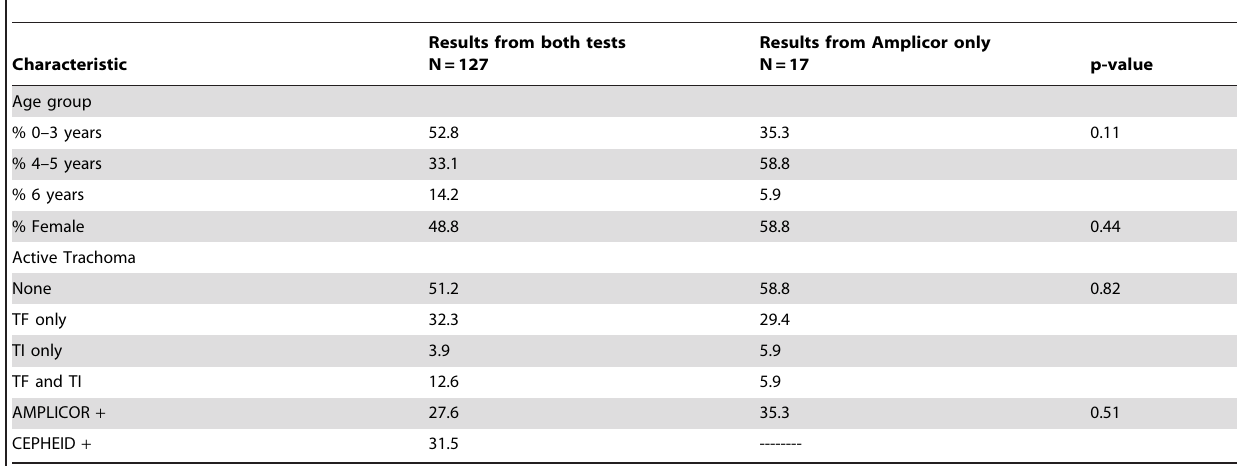
Table 1. Characteristics of the children in sample according to number of tests results.